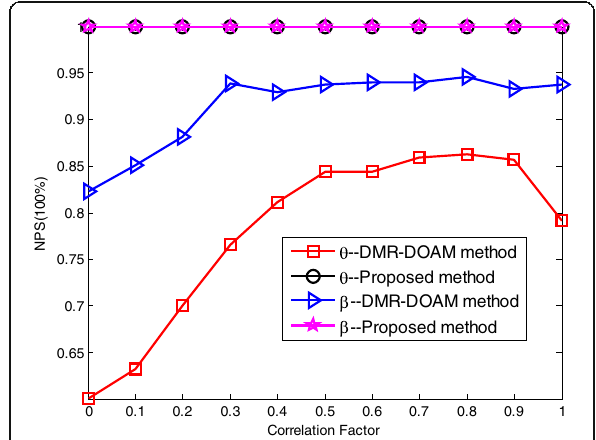
Fig. 7 The NPS of the DOA estimates versus correlation